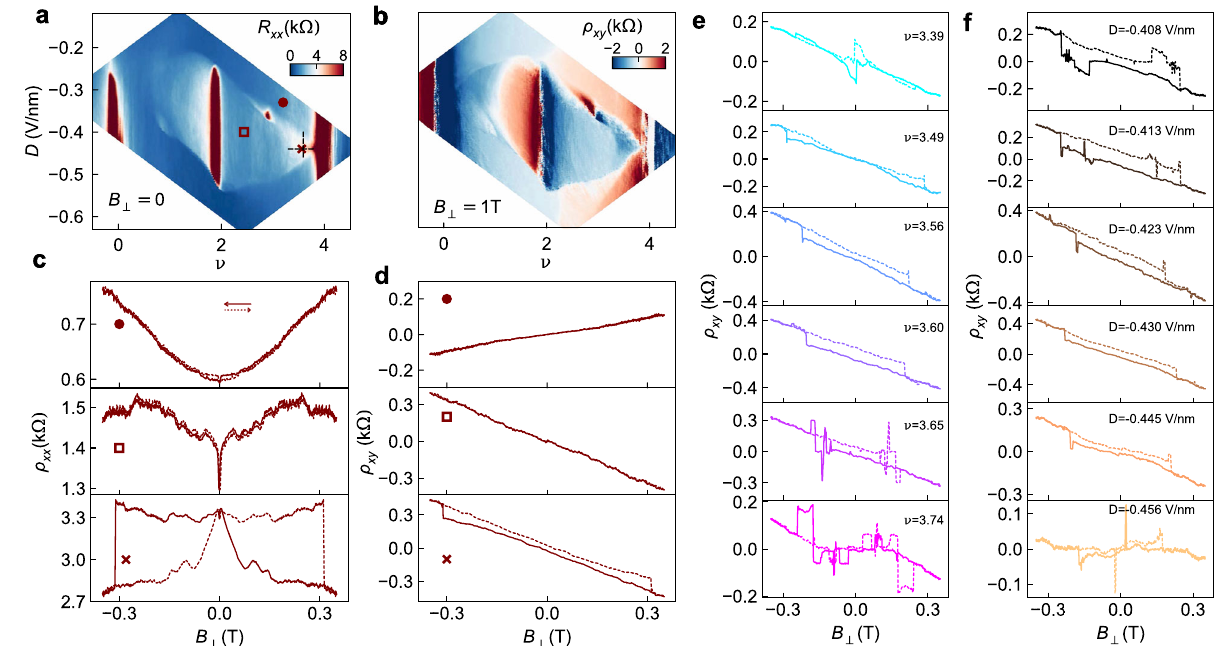
Fig. 2 | Out-of-plane magnetoresistance.a R xx asfunction of ν and D showing the correlated insulating states at ν =2 and ν =3, appearing in red by the colour scale chosen here, surrounded by a halo region that is metallic but higher resistance (light blue) than the surrounding areas (dark blue). b Anti-symmetrized Hall resistance, ρ xy , for ∣ B ⊥ ∣ =1T. The Hall resistance changes sign at integer fi llings and also at the boundary of the halo region. c , d Magnetic fi eld dependence of the